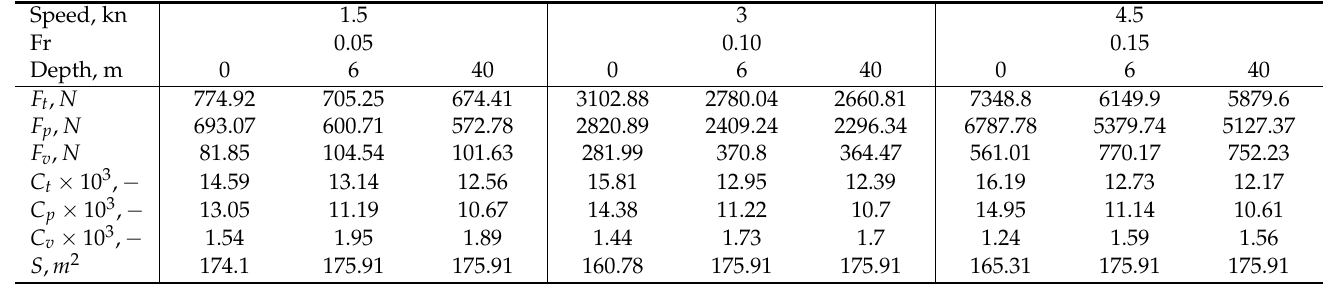
Table 4. Resistance results for the cylindrical pressure hull with ring protrusions, Geometry 2.